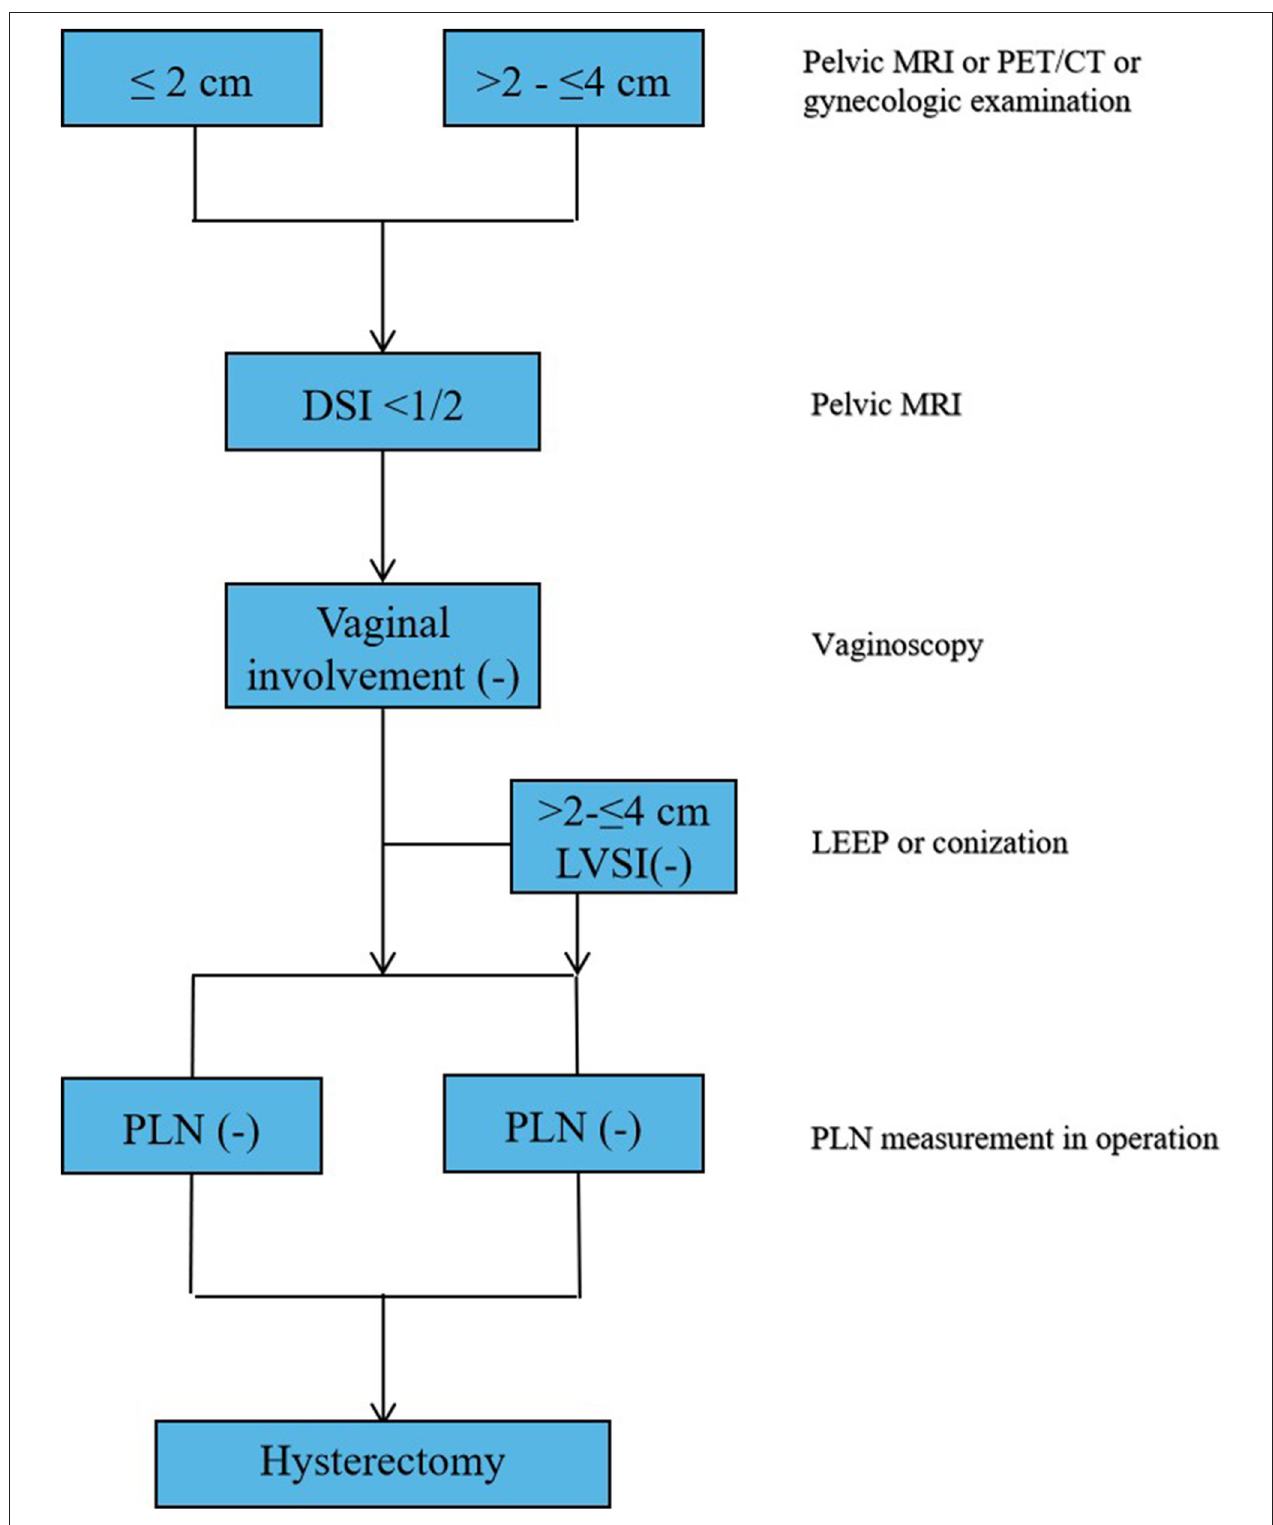
FIGURE 4 | Summary of the main outcomes in this study.